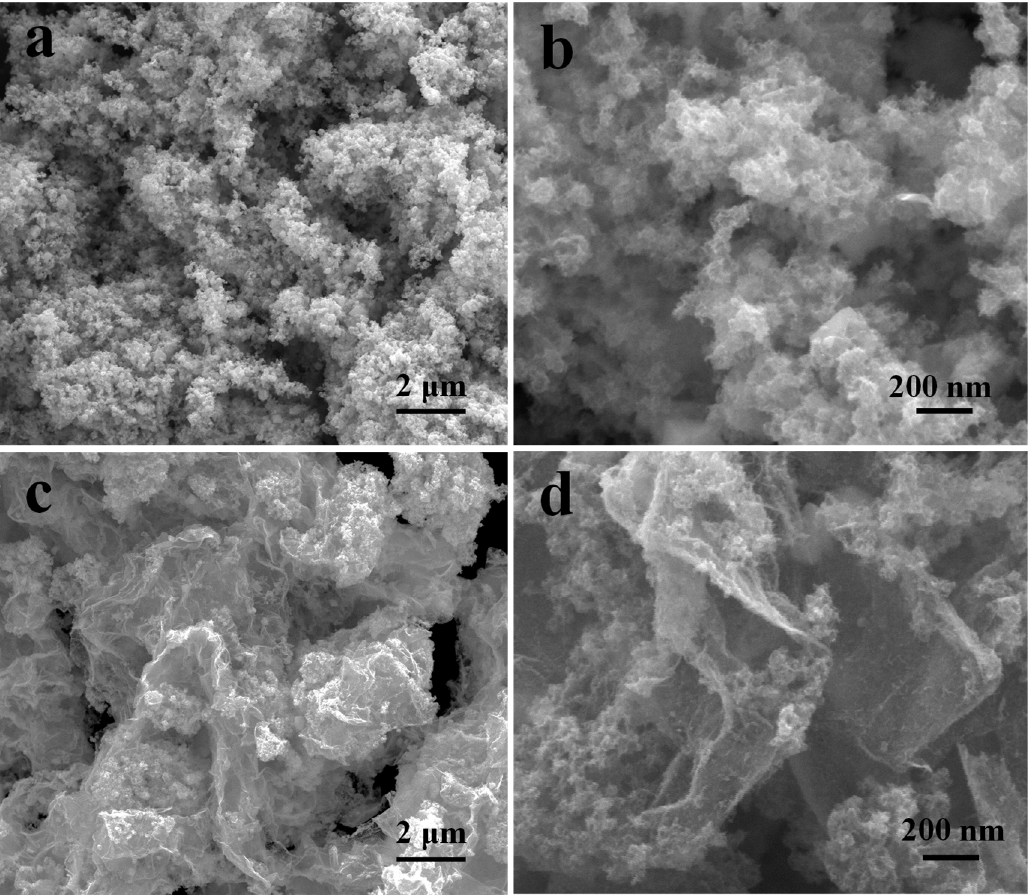
Figure 3. ( a , b ) SEM images of NiSe 2 -MoSe 2 HTs. ( c , d ) SEM images of NiSe 2 -MoSe 2 HTs/G